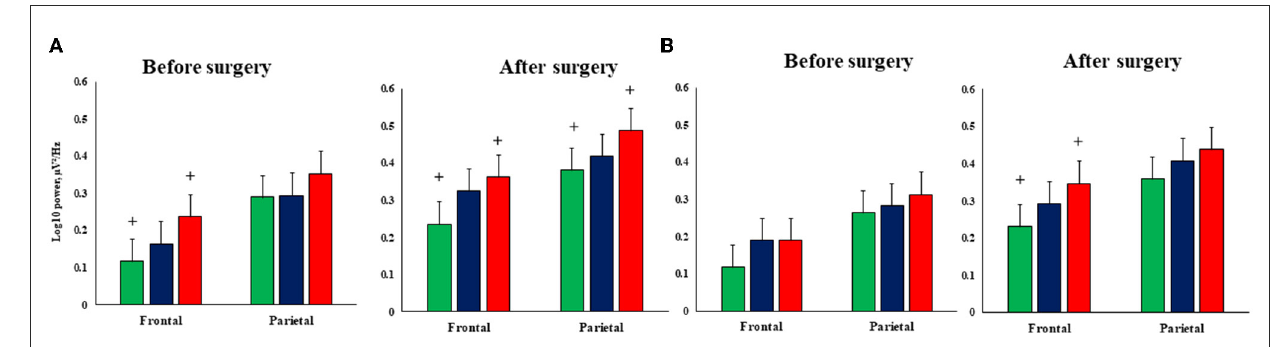
FIGURE5 Topography of the postoperative theta1 rhythm power changes in the patients undergoing isolated CABG and simultaneous intervention (CABG + CEA). (A) —Left hemisphere, (B) —right hemisphere; green columns—isolated CABG, blue columns—left-sided CEA + CABG group, red columns—right-sided CEA + CABG group. + indicates the significance level p ≤ 0.05 in between-group